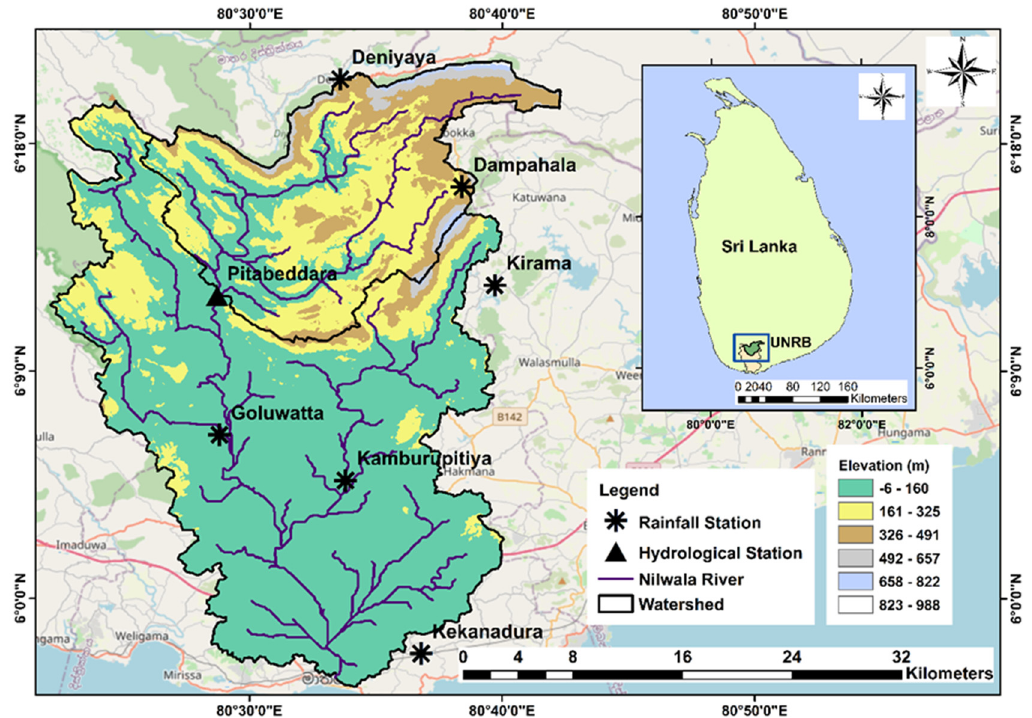
Figure 1. Location map of Nilwala River Basin with rainfall and hydrological stations.